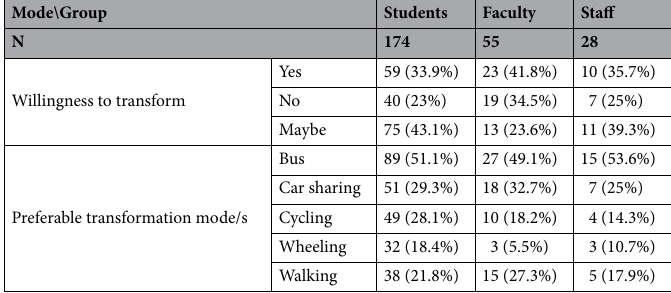
Table 12. Willingness to transform traveling modes to the campus.